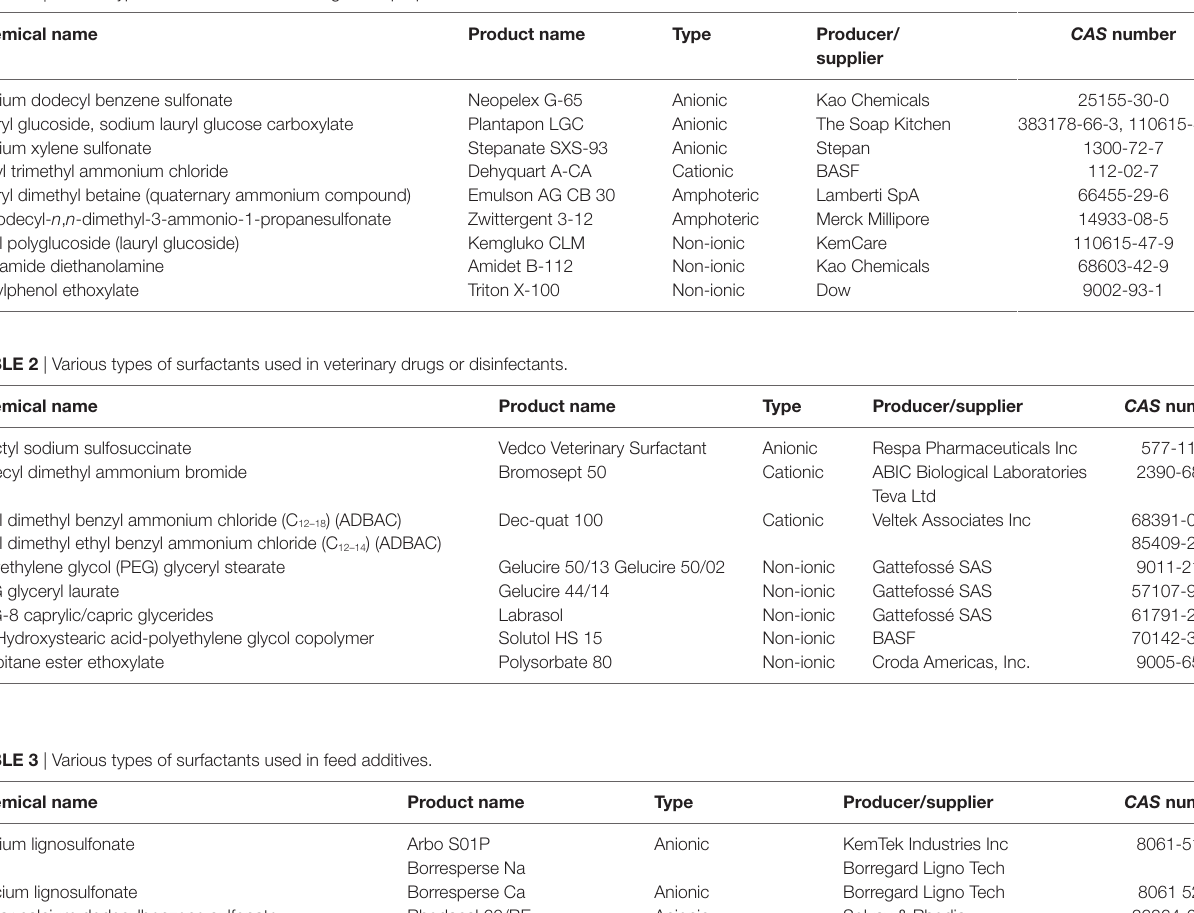
TABLe 1 | Various types of surfactants used for general